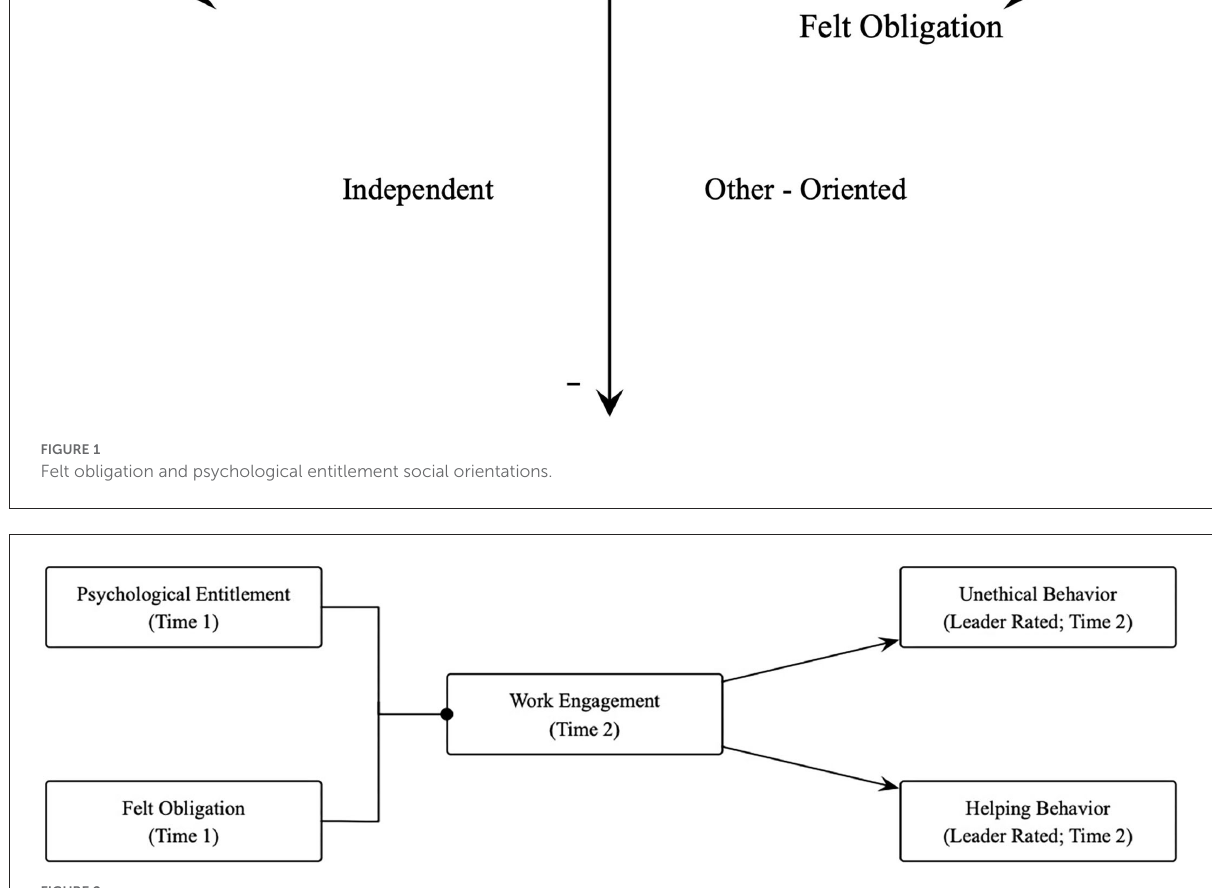
FIGURE2 The conceptual